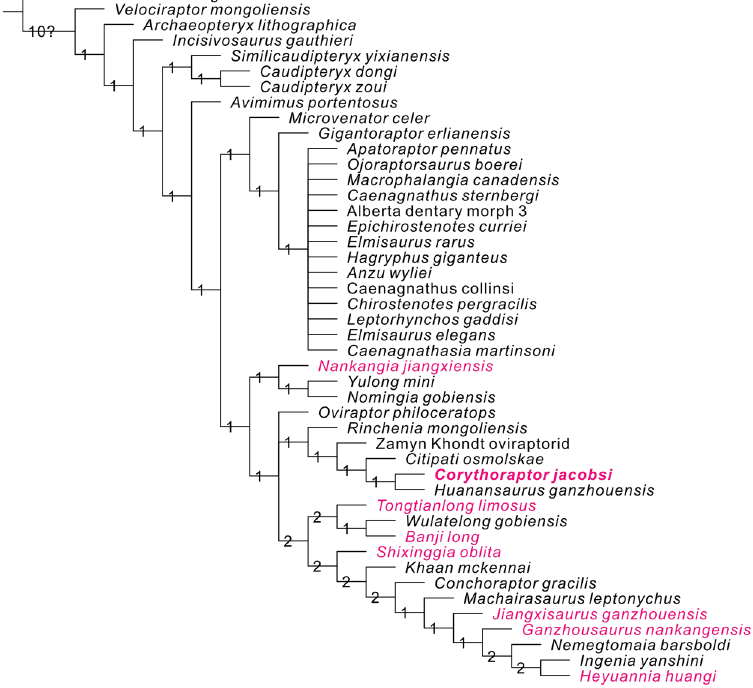
Figure 3. Strict consensus of 4151738 most parsimonious trees obtained by TNT, based on analysis of 45 taxa and 257 characters, showing the phylogenetic position of Corythoraptor jacobsi gen. et sp. nov. (Tree length = 623). Numbers adjacent to each node are Bremer support values. Oviraptors from southern China are in